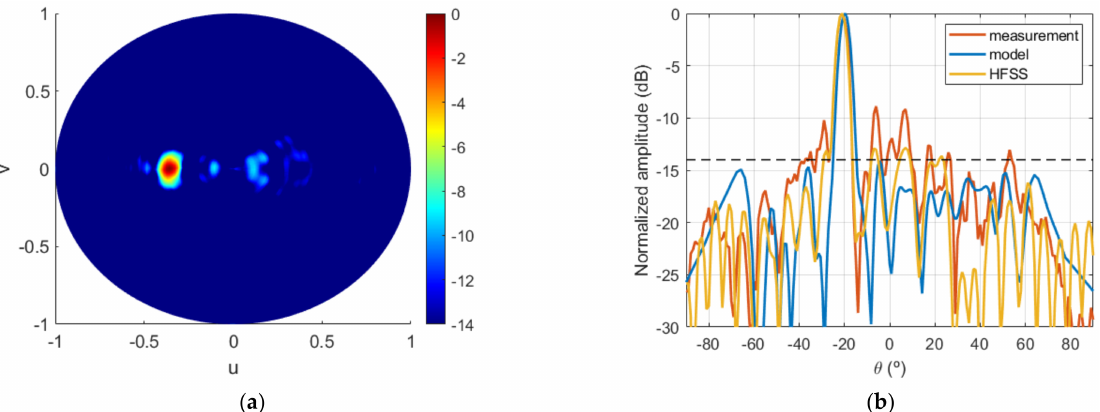
Figure 20. Case 2, FF results of the prototype: ( a ) measured radiation pattern (normalized amplitude, dB); ( b ) comparison of model result and measurement for cut v =